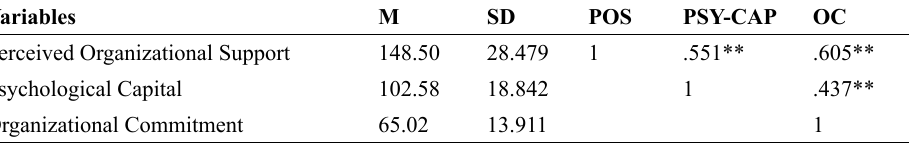
Mean, Standard Deviation and Correlation Matrix among Perceived Organizational Support (POS), Psychological Capital (PS-Cap) and Organizational Commitment (OC) Variables